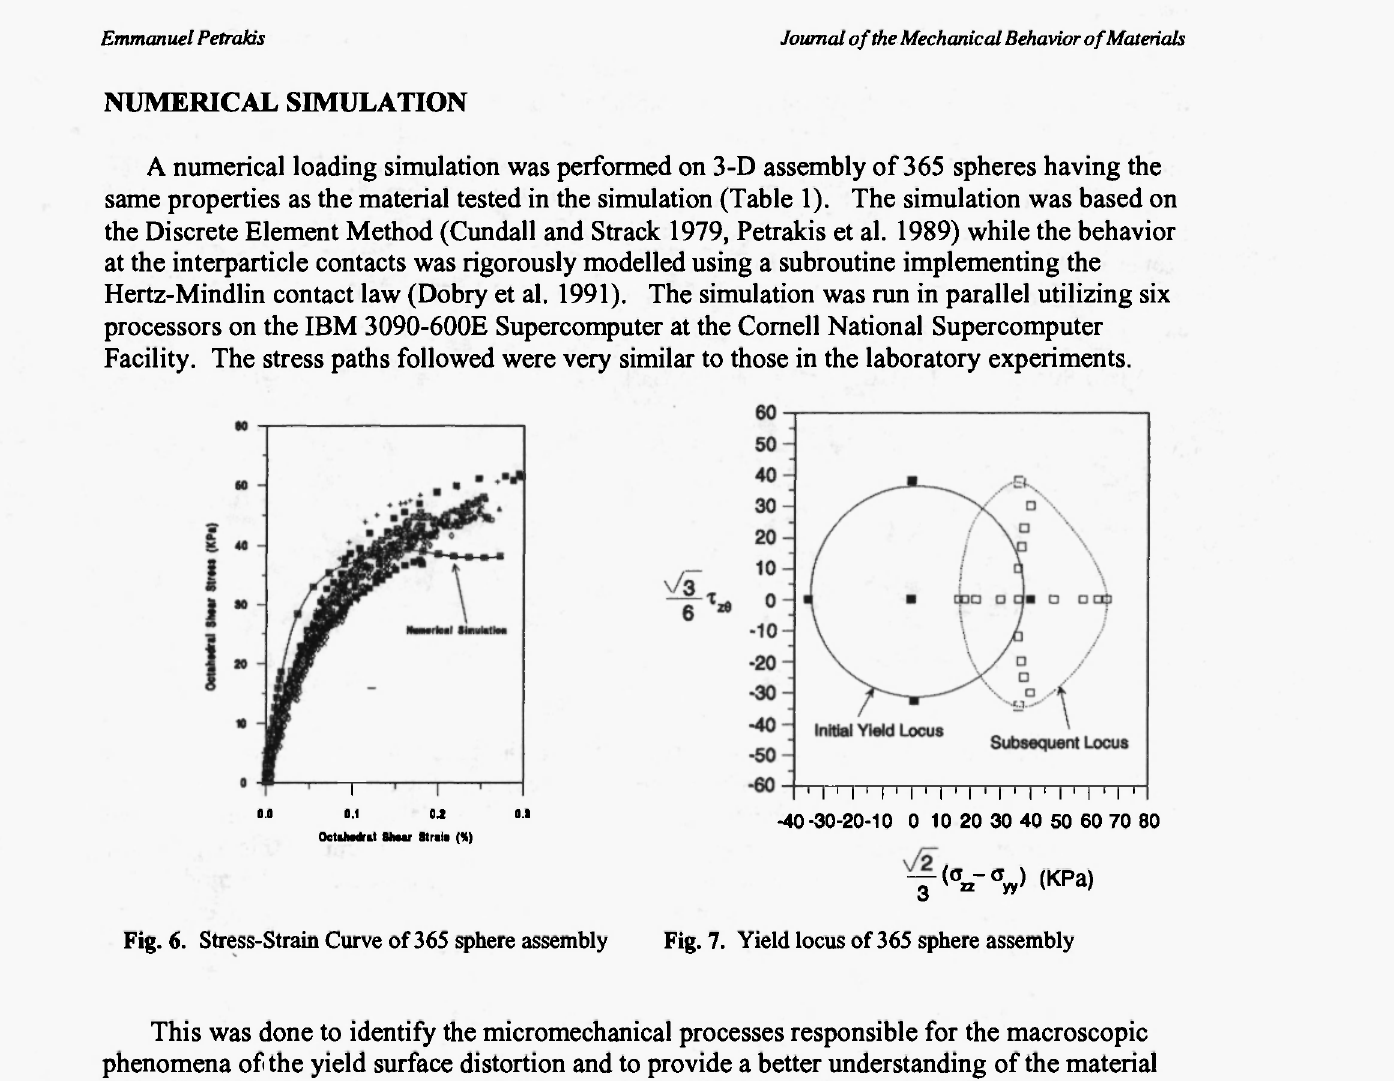
Fig. 6. Stress-Strain Curve of 365 sphere assembly Fig. 7. Yield locus of 365 sphere